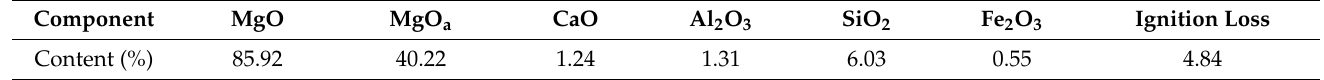
Table 2. Chemical composition of the MgO